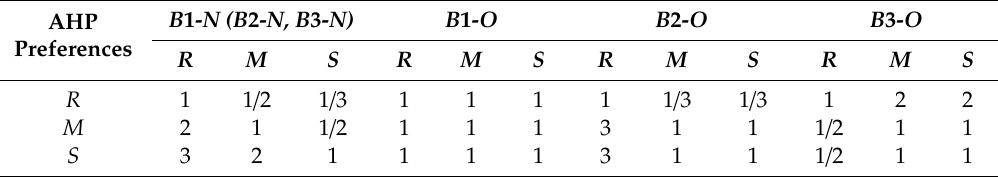
Table 6. The ranking of partial indicators of the availability of new and old